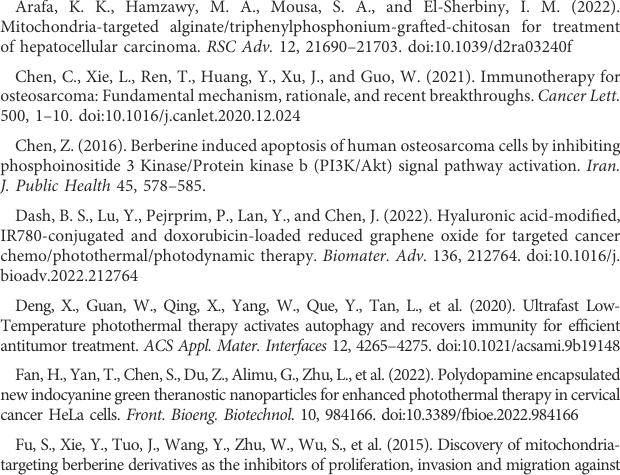
Figure S3, the levels of ALT and BUN were all within normal range. Over all, all these results collectively certi fi ed the excellent synergistic antitumor effects and remarkable systemic safety of the mitochondria- targeting